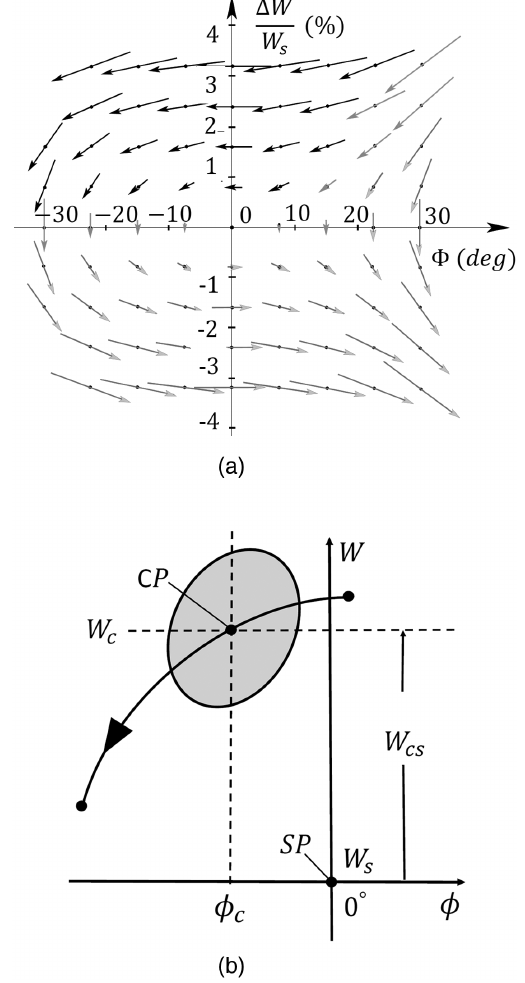
FIG. 4. (a) Single-particle motion around the zero degree synchronous particle. (b) Typical trajectory of the bunch center along a zero degree KONUS drift tube section with a limited number of